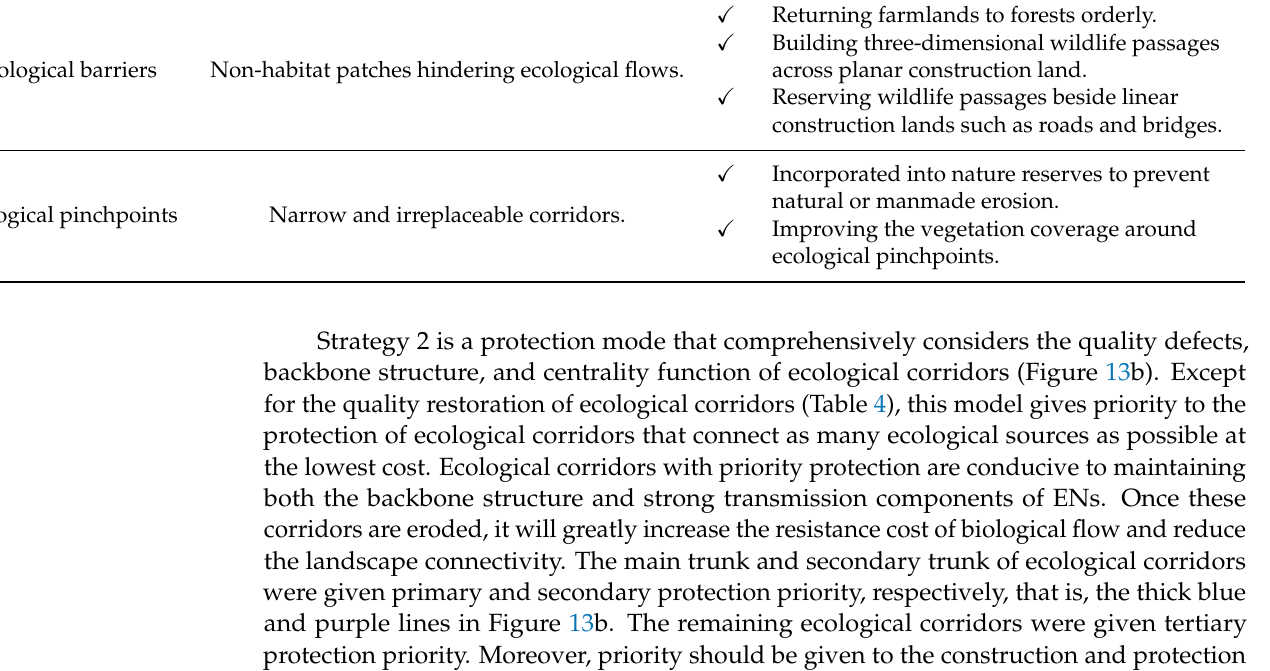
Table 4. Quality defects and restoration strategies of ecological corridors in WUA. Types Characteristics Strategies (cid:88) Returning farmlands to forests orderly. (cid:88) Building three-dimensional wildlife passages across planar construction land. Ecological barriers Non-habitat patches hindering ecological flows. (cid:88) Reserving wildlife passages beside linear construction lands such as roads and bridges. (cid:88) Incorporated into nature reserves to prevent natural or manmade erosion. Ecological pinchpoints Narrow and irreplaceable corridors. (cid:88) Improving the vegetation coverage around ecological